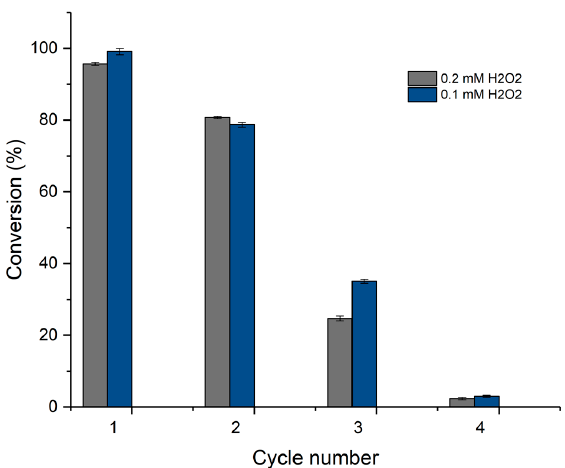
Figure 7. Recyclability of the CPO–chitosan macrospheres for ketorolac oxidation at two hydrogen peroxide concentrations.